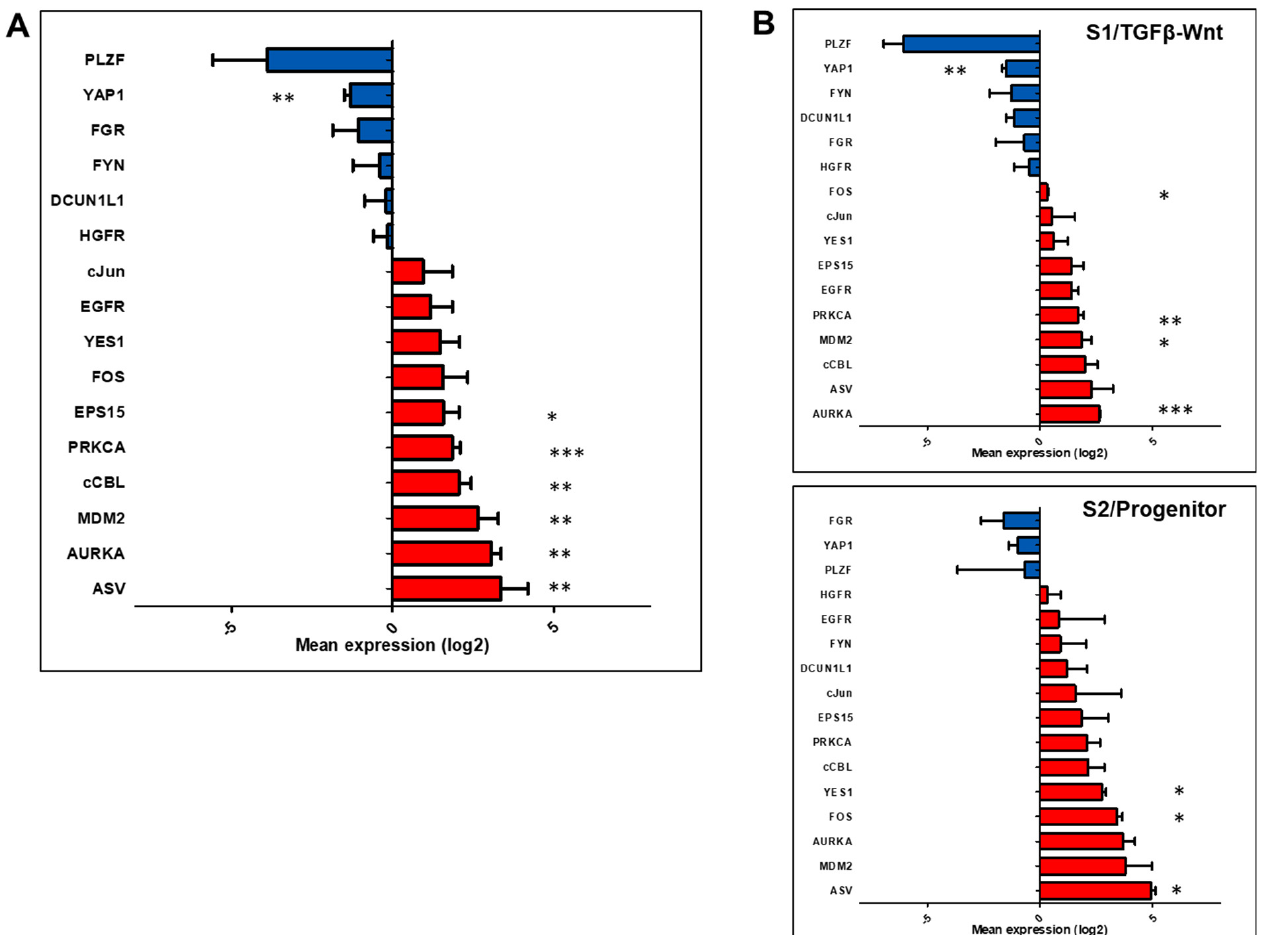
Figure 2. Baseline mRNA expression of targets in the various HCC cell populations. ( A ) Distribution of targets showing the upregulated and the down-regulated proto-oncogenes. ( B ) Distribution of relative expression of candidate targets between the S1 and S2 cell populations. Data are presented as the mean expression values (log2) from three independent samples of each cell lines. Statistical analysis: * p < 0.05, ** p < 0.01, *** p < 0.001 using the one-sample t -test vs. mean expression of immortalized hepatocytes IHH as 0.00. Red—up-regulated, Blue—down-regulated.